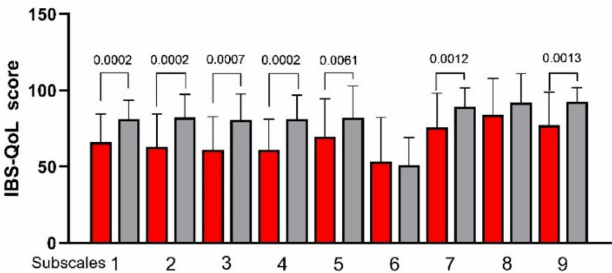
Figure 4. The IBS Quality of Life (IBS-QoL) total and subscale scores before and after low FODMAPs diet. Data are presented as mean ± SD. Statistical analysis: Wilcoxon matched-pairs signed-rank test with a significant difference set at p < 0.05. Subscales: (1) Total Score; (2) Dysphoria; (3) Interference with Activity; (4) Body Image; (5) Health Worry; (6) Food Avoidance; (7) Social Reaction; (8) Sexual Concerns; (9) Relationship.